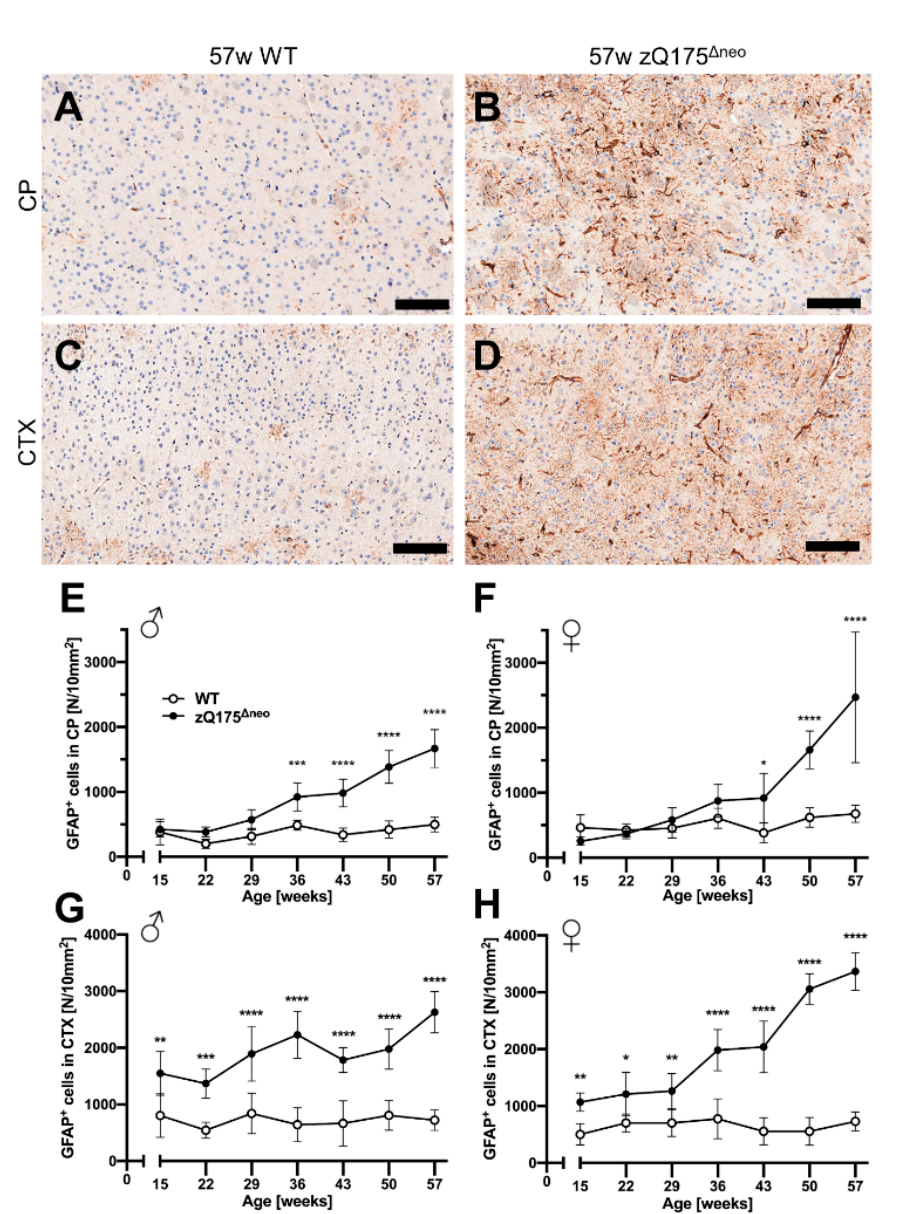
Figure 8. Reactive astrogliosis was observed in the caudate-putamen (CP) from 36 or 43 weeks of age, respectively, and cerebral cortex (CTX) already from 15 weeks of age of zQ175 ∆ neo mice compared to WT littermates. ( A – D ) Coronal brain sections from 57-week-old WT and zQ175 ∆ neo mice were immunohistologically stained for GFAP. GFAP + astrocytes were detected using a deep-learning algorithm. Representative images of the GFAP-stained CP ( A , B ) and CTX ( C , D ) of 57-week-old female WT ( A , C ) and zQ175 Δ neo mice ( B , D ). The scale bars indicate 50 µm. Male ( E , G ) and female ( F , H ) zQ175 Δ neo mice ( ● ) showed an increase of GFAP + astrocytes compared to WT littermates ( ○ ) in both CP ( E , F ) and CTX ( G , H ). Data are presented as mean ± SD; N = 5–6. Significance was calculated using two-way ANOVA with Bonferroni’s multiple comparisons test and is given as *: p ≤ 0.05, **: p ≤ 0.01, ***: p ≤ 0.001, and ****: p ≤ 0.0001.